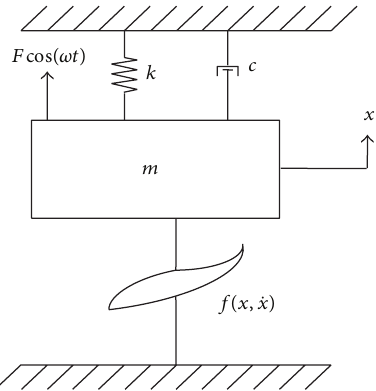
Figure 1: Asymmetric hysteresis dynamical